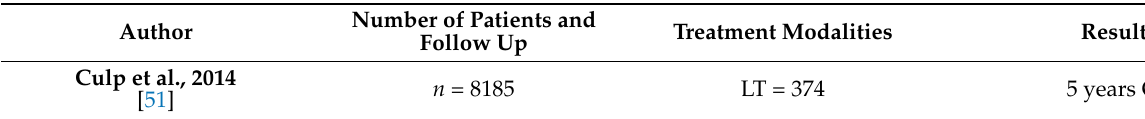
Table 3. Retrospective trials for metastatic prostate